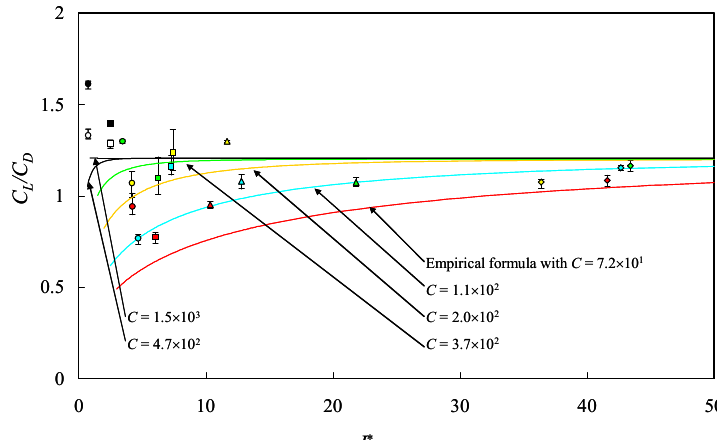
Fig. 14 Lift-drag ratio C L / C D versus inertia moment ratio I * , for λ = 0.3, AR = 10, C = 7.2 × 10 1 − 1.6 × 10 3 and I * = 0.75 − 43. Empirical formula is given by Eq. (26).